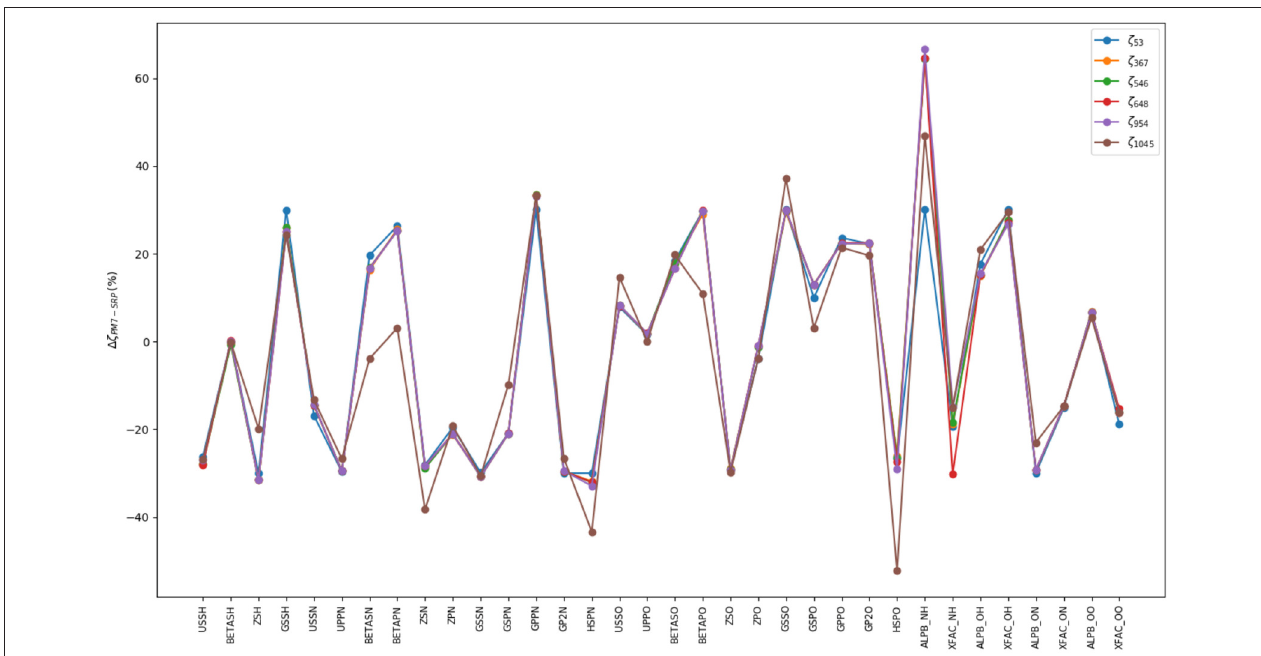
FIGURE 4 | Percentage of variation of the SRP parameters with respect to the original PM7 ones. Each fitting stage is represented by its optimal parameters, ζ N , where N is the number of points used in the process (see Table 1 ). On abscissas we present the label of semiempirical parameters for the different type of atoms in HONO. Standard semiempirical parameter labeling has been used ( Stewart, 2013). Parameters from USSH until HSPO correspond to a single type of atom whereas parameters labeled ALPB XY and XFAC XY correspond to two-atom ones (atom X and atom Y).